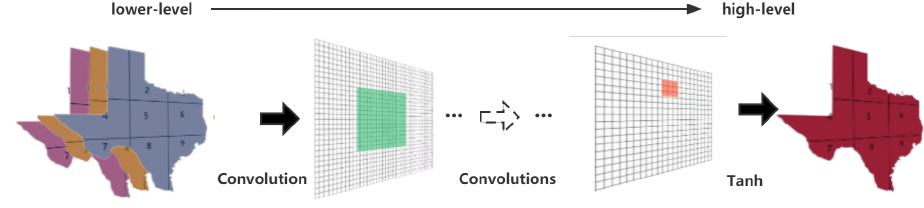
Figure 4. Schematic diagram of convolution structure. The lowest order Teaxs map with different colors represents the multiple layers of input, and the arrows represent the deepening of the convolution layers and the subse- quent focusing of the convolution kernel. The final result is activated by the activation function